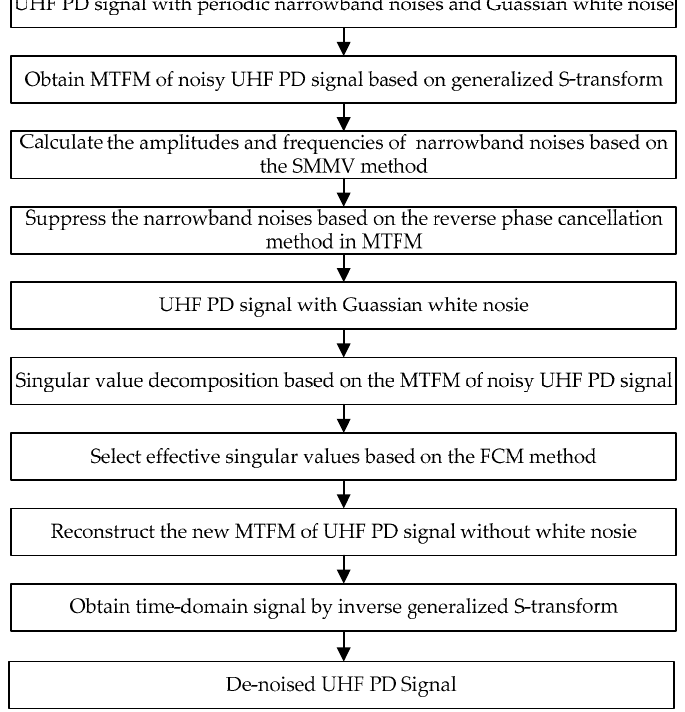
Figure 10. Procedure of the proposed de-noising method.